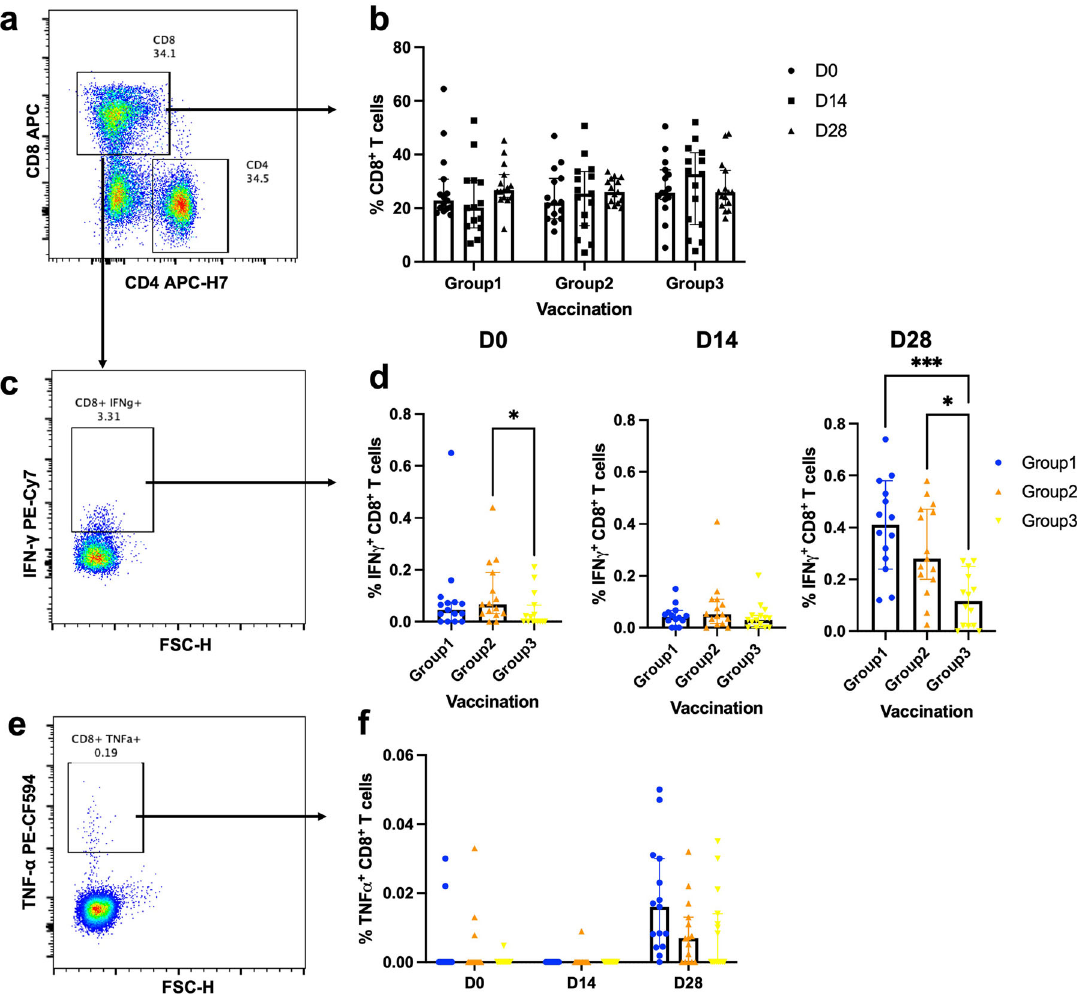
Fig. 6 Effector cytokine production of S1-speci fi c CD8 + T cells after boosting. All volunteers were previously vaccinated with two doses of inactivated SARS-CoV-2 vaccines. After 4 – 8 weeks (Group2) and 8 – 12 weeks (Group3), the fractional dose of a viral vector vaccine booster was delivered intradermally. A full dose of intramuscular viral vector booster was also given at 4 – 8 weeks as a control (Group 1). Blood was taken before (D0) and after the booster dose for 14, 28 days (D14, D28). The blood samples were processed to obtain PBMCs. The frozen PBMCs were thawed and stimulated with S1 peptide pools. The cells were stained and analysed using fl ow cytometry. a Representative fl ow plot shows CD8 + T cell and CD4 + T cell populations. b Percentage of CD8 + T cells before and after the booster dose. c CD8 + T cells were then selected for S1-speci fi c IFN- γ producing cells. d Percentage of S1-speci fi c IFN- γ producing CD8 + T cell responses at D0, D14, and D28. e Representative fl ow plot shows CD8 + T cells producing S1-speci fi c TNF- α . f S1-speci fi c TNF- α producing CD8 + T cells. Each symbol represents